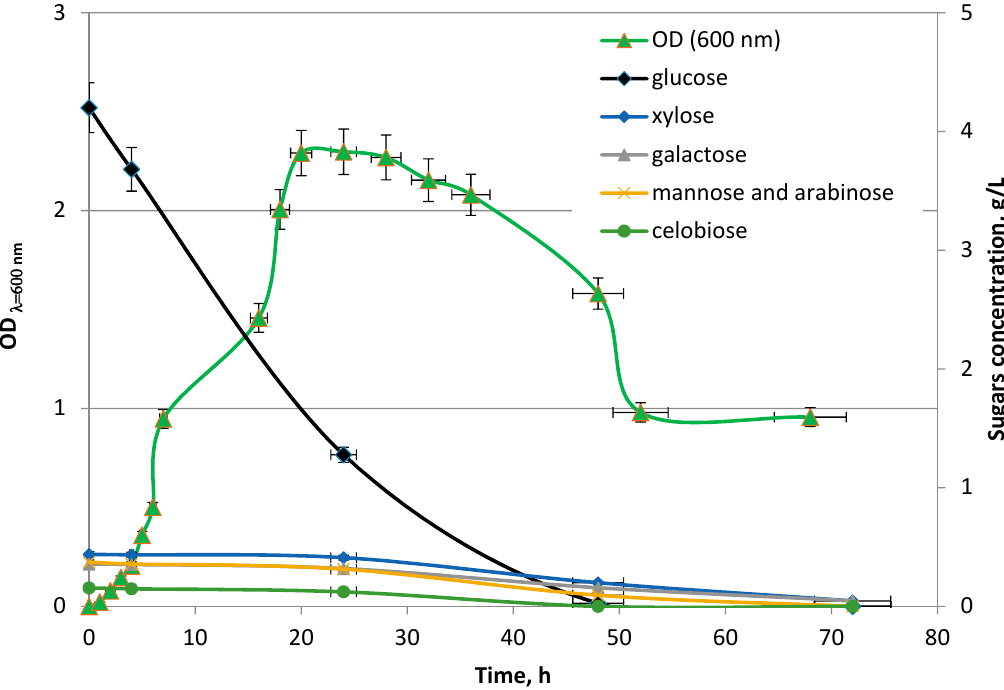
Figure 9. Changes in the sugar concentration corresponding to changes OD λ =600 values during dark fermentation.